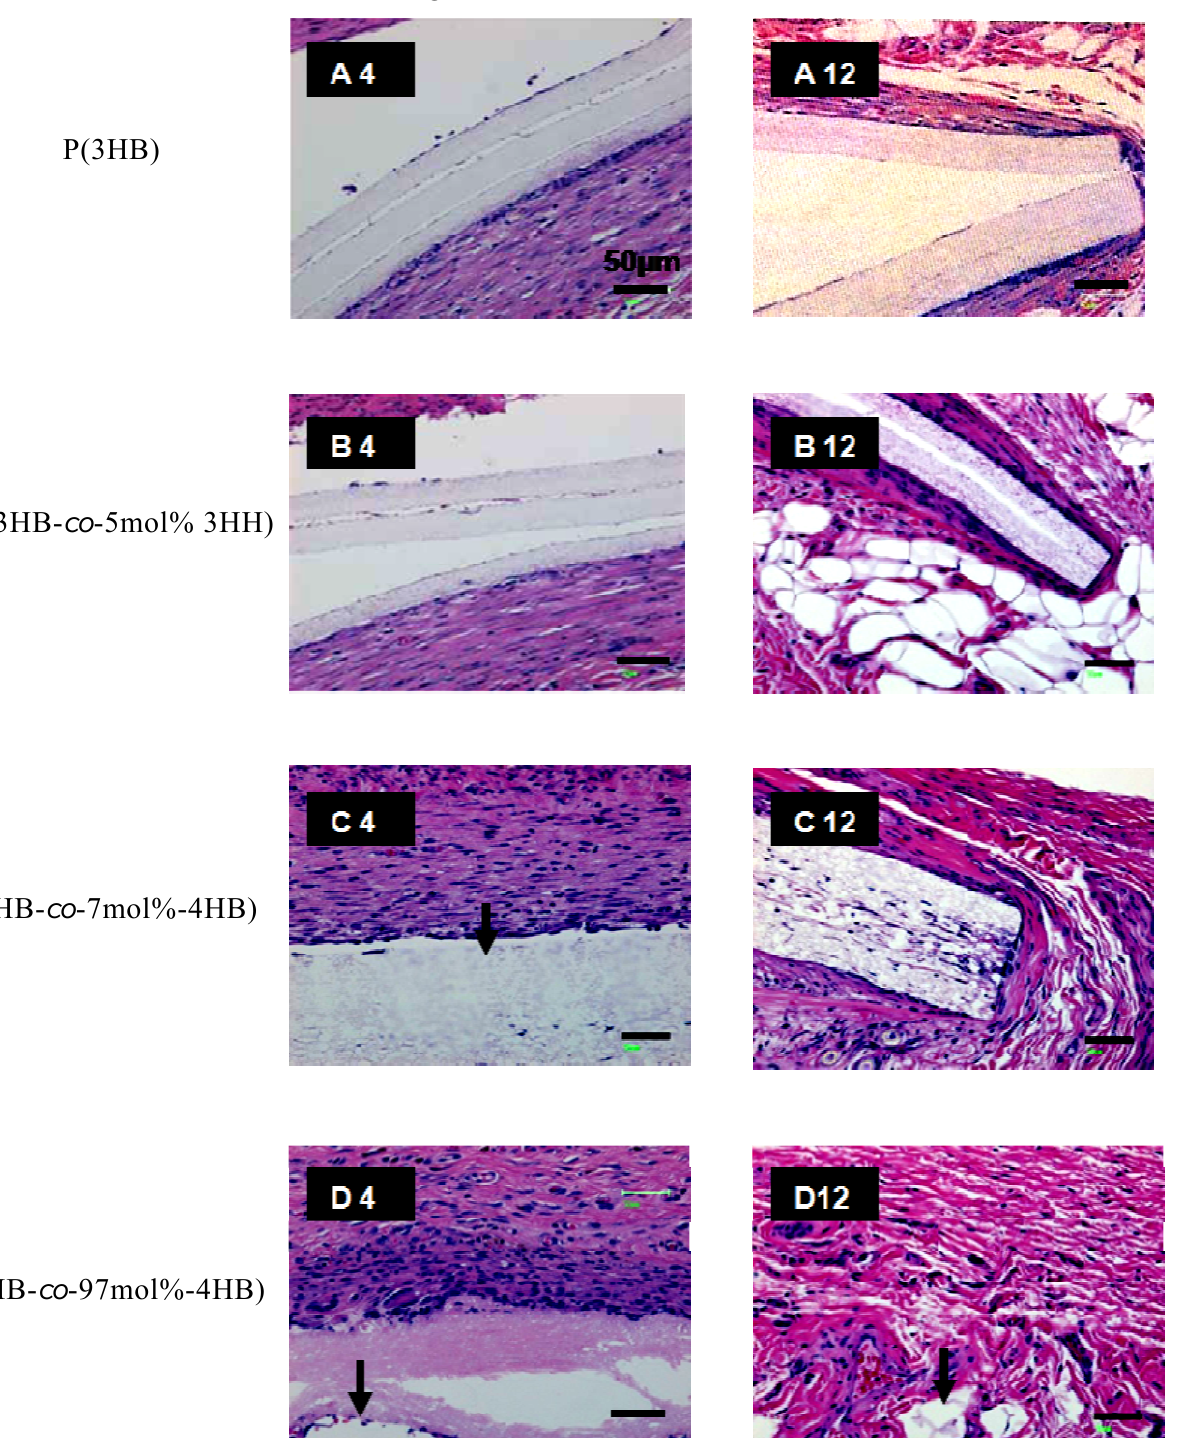
Figure 8. Phase contrast images of hematoxylin-eosin stained ultrathin sections of